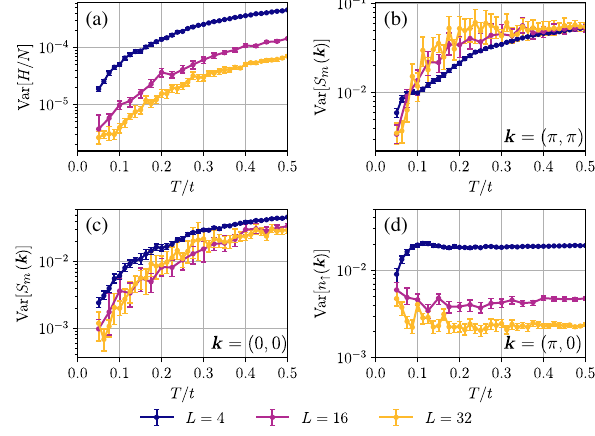
FIG. 16. Comparison of energy time series and autocorrelation FIG. 17. Lattice size and temperature dependence of the functions ρ ½ H (cid:4)ð l Þ obtained using S z and S x collapses for T=t ¼ variance of time series of METTS measurements for U=t ¼ 10 0 . 400 , U=t ¼ 10 at half filling on a 16 × 4 cylinder. We use time- and hole dopings p ¼ 1 = 8 cylinder for L ¼ 4 , 16, 32. We use 2000 and ε ¼ 10 − 6 . (a),(b) S z -basis 2000 and ε ¼ 10 − 6 . Error bars evolution parameters D time-evolution parameters D max ¼ max ¼ collapse. Autocorrelation effects are visible in the raw data. (c),(d) indicate a 95% confidence interval. (a) Energy measurements. We S x -basis collapse.Noautocorrelationeffectsareapparentinthe time observe a fast decrease of the variance as lowering temperature. series. The autocorrelation function quickly decays to numerical (b) Magnetic structure factor S ð k Þ at ordering vector k ¼ ð π ; π Þ . noise. Subsequent measurements are essentially uncorrelated. (c) Magnetic structure factor S ð k Þ at k ¼ ð 0 ; 0 Þ . (d) Momentum distribution function n ↑ ð k Þ at k ¼ ð π ; 0 Þ . factor of k ¼ ð 0 ; 0 Þ variances in Figs. 18(a) and 18(c) do not depend strongly on the filling fraction. We observe a rapid decrease of the variance when lowering the temper- ature. In contrast, the variance of the magnetic structure factor evaluated at M ¼ ð π ; π Þ in Fig. 18(b) does not rapidly decrease at half filling. This can be attributed to